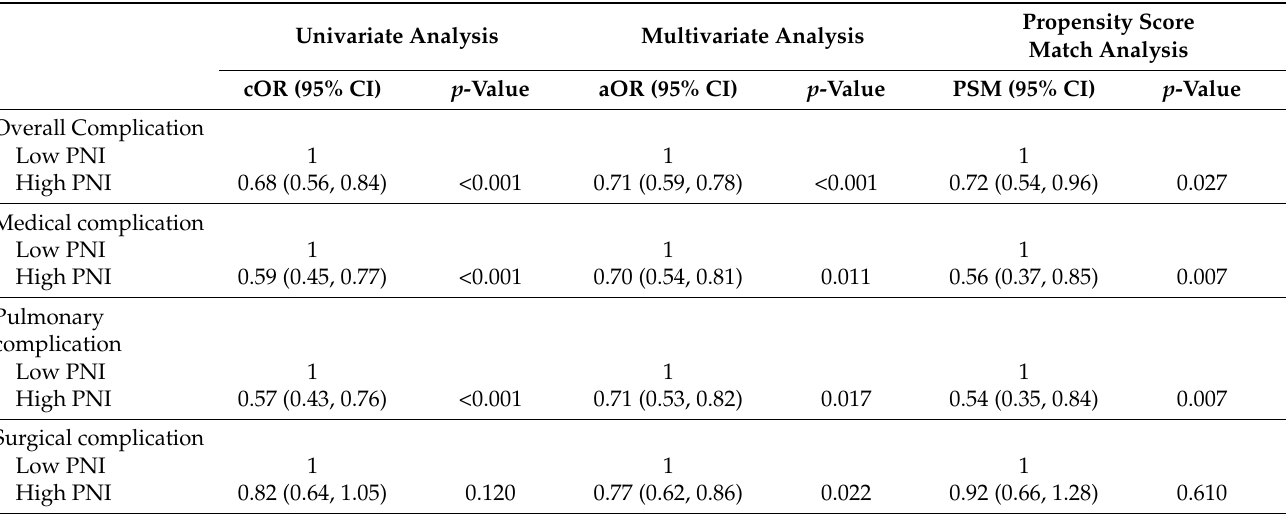
Table 2. Univariate and multivariate analyses of postoperative complication events in the PNI group using before and after propensity score-matched datasets. Univariate Analysis Multivariate Analysis